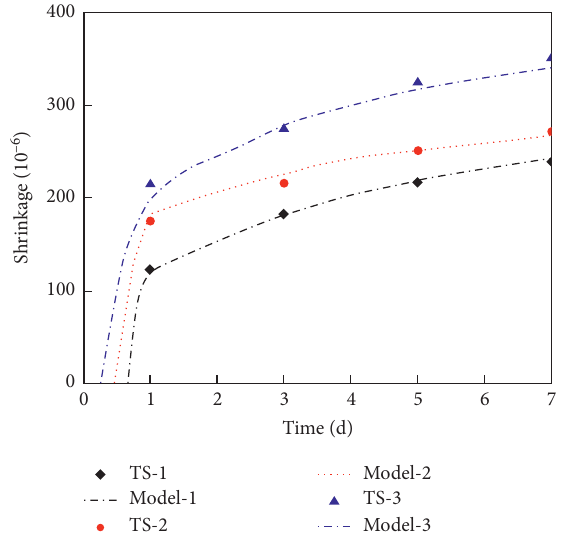
Figure 8: Experimental and predicted values of concrete shrinkage and age.